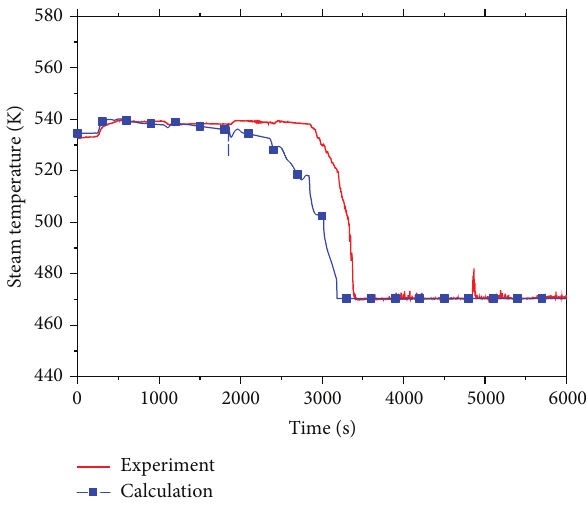
Figure 12: Steam temperature at the SG